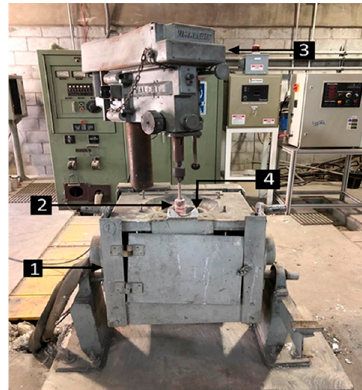
Figure 1. Scheme of the induction furnace with a mechanical agitator used as experimental apparatus (1. Induction furnace, 2. Graphite paddle, 3. Mechanical agitator, and 4. Liquid aluminum).